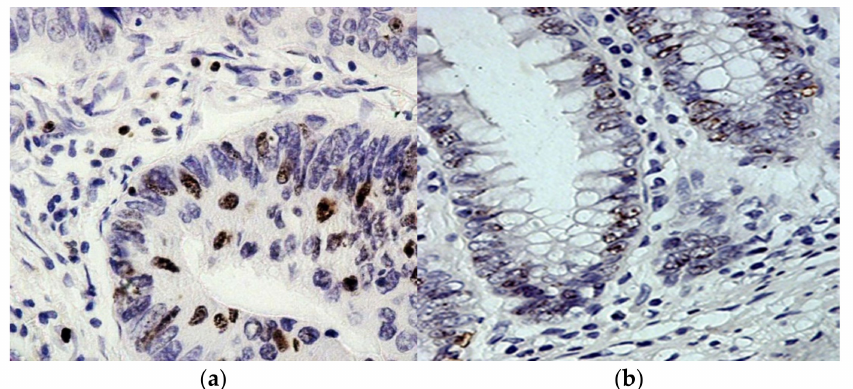
Figure 3. Immunohistochemical reaction with antibodies to cycline D1 in adenocarcinoma and resection region. ( a ): cycline D1 expression is determined in the nuclei of RC cells; ( b ): cycline D1 expression in colonocytes in crypts at the resection edge. Chromogen–diaminobenzidine. Control of hematoxylin staining. Magnification: × 400.